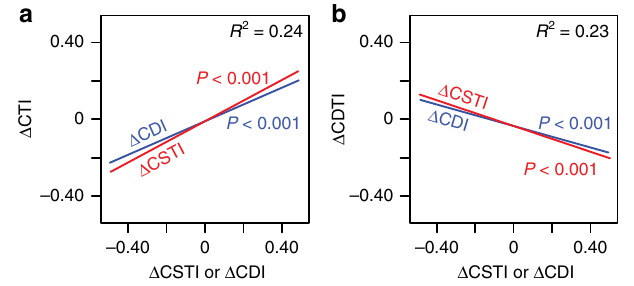
Fig. 4 Relationships between changes in different community indices. Linear mixed models: a Δ CTI against Δ CSTI and Δ CDI, and b Δ CDTI against Δ CSTI and Δ CDI. P values are shown for each line and the conditional R 2 values are shown in the upper right corners. CTI community temperature index, CDTI community drought tolerance index,